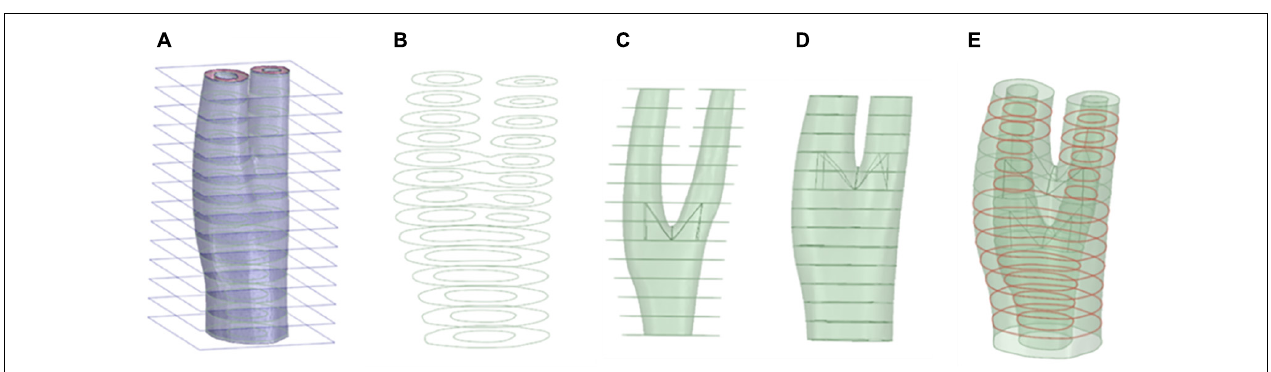
FIGURE 1 | Geometry preparation steps. Sectioning the geometry and extraction of the curves (A,B) , respectively. (C) Skin the inner surface, (D) Skin the outer surface, (E) Stitching the geometry surfaces where required (red curve).